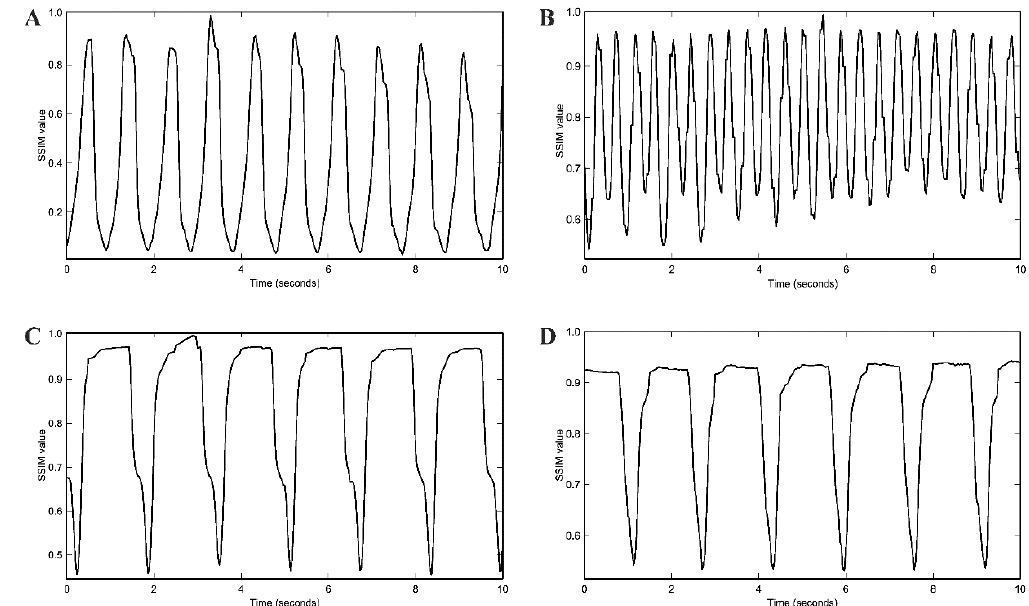
Figure 6. Spontaneous beating rate of cardiac pacemaker cells differentiated by protocol E. Cell video recording was performed using an inverted microscope equipped with a camera. Video analysis was realized by applying ImageJ software (Version 1.53) and structural similarity approach. ( A ): Basal spontaneous beating rate. ( B ): Spontaneous beating rate upon stimulation with 1 µM isoproterenol. ( C ): Spontaneous beating rate upon treatment with 1 µM carbachol. ( D ): Spontaneous beating rate upon treatment with 3 µM ivabradine. Abbreviation: SSIM: pair-wise similarity value.